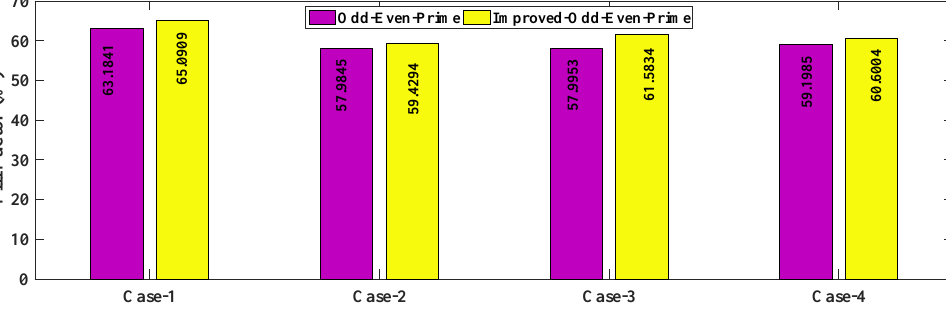
Figure 13. Fill-factor for 9 × 9 PV